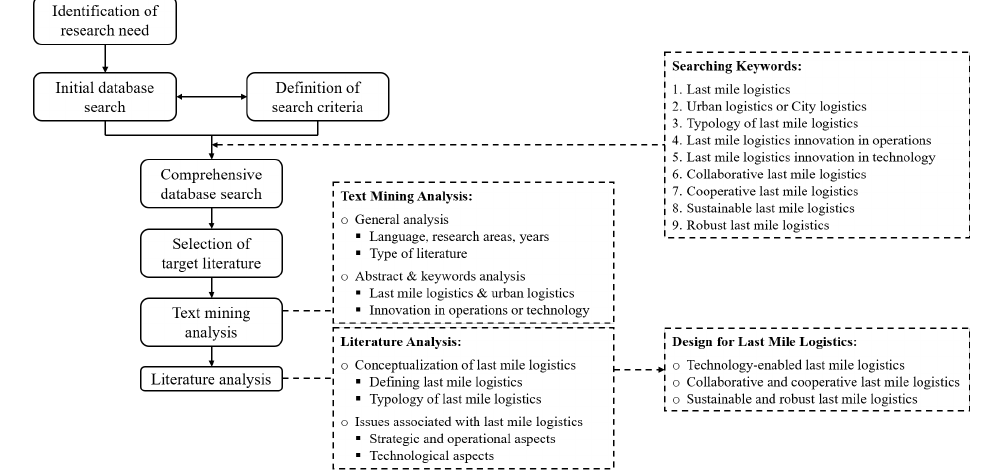
Figure 3. Framework for systematic literature